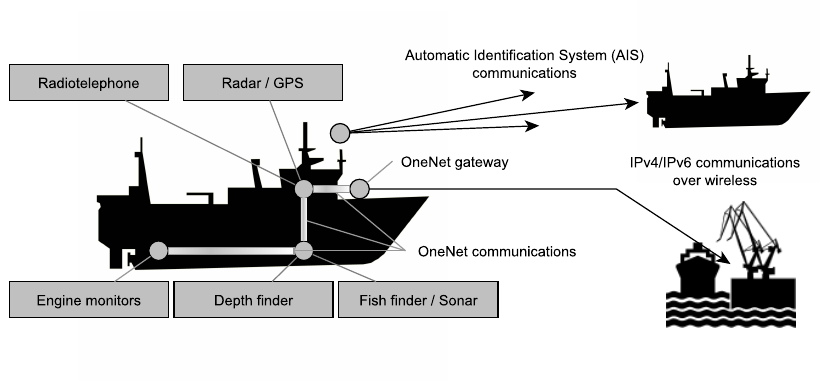
Figure 1. Network protocols utilized by a marine vessel and their interactions with other adjacent vessels or coastal services. National Marine Electronic Association (NMEA) OneNet communications require a gateway that translates packets for IP networks. Automated Identification System (AIS) is broadcasted to other ships via radio